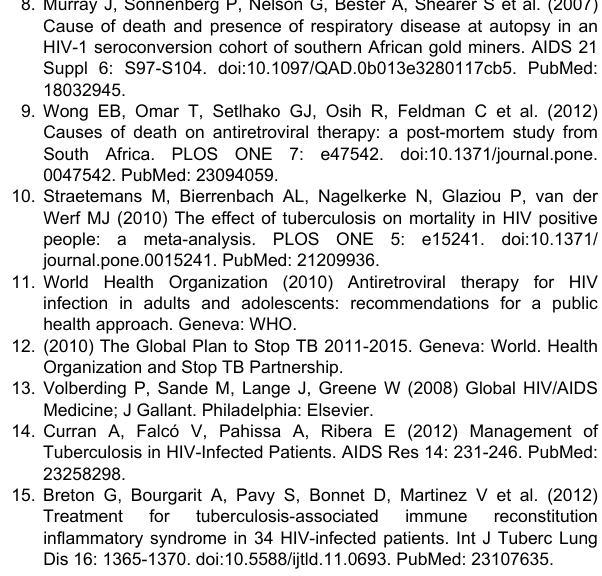
Table S4. Median (IQR) baseline CD4 cell count by TB treatment status, if available.